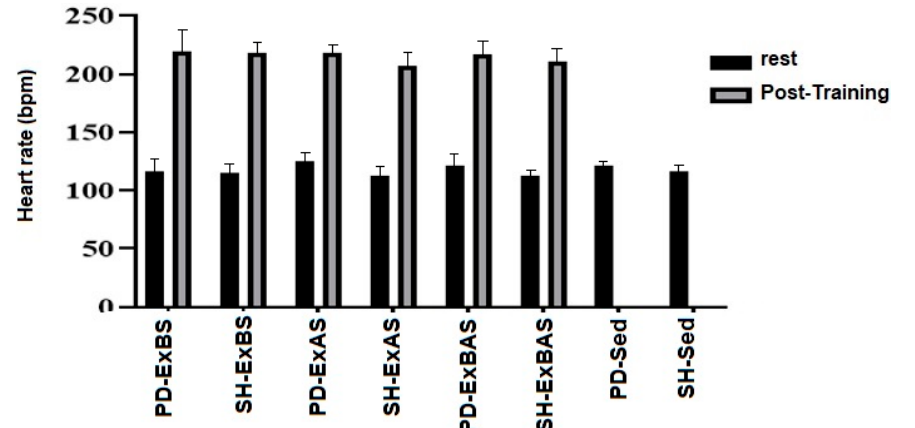
Figure 5. Analysis of mean heart rate at rest and after physical training among groups. The relation- ship between body weight and heart weight (Figure 4) showed no significant differences in the PD and SH animals belonging to the same training or sedentary protocols ( p = 0.86).